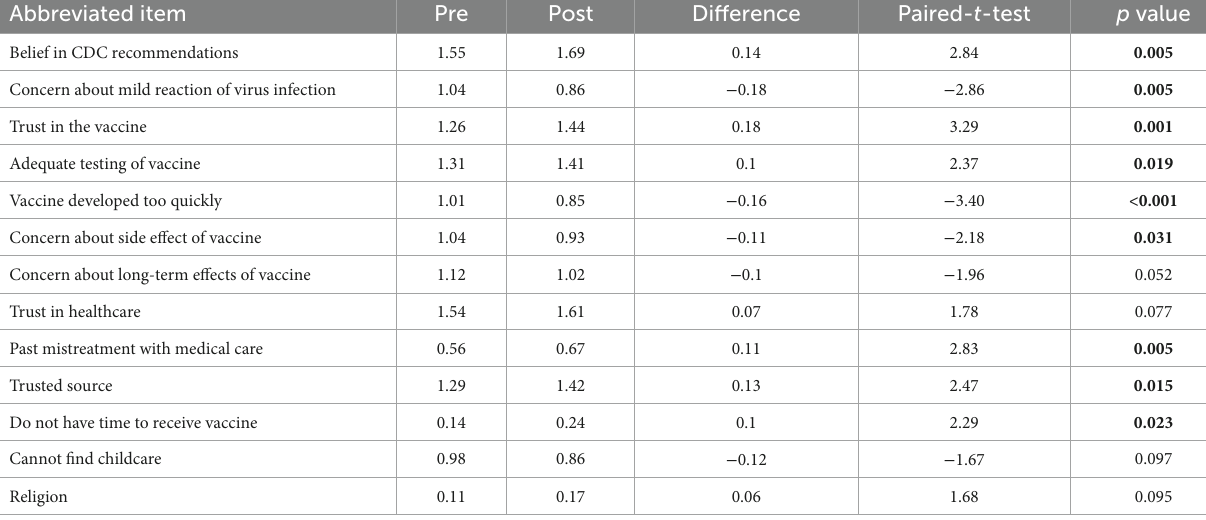
TABLE 2 Mean item virus and vaccine attitude difference scores ( N =